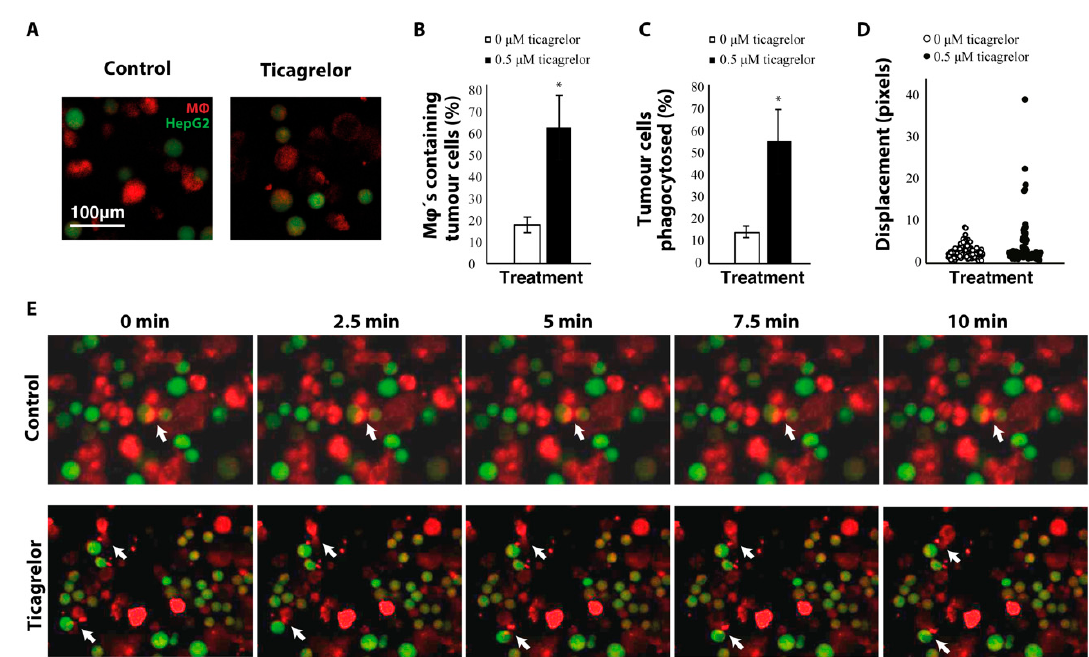
Figure 4. Ticagrelor enhances phagocytosis of tumor cells. ( A ) Confocal microscopy images of macrophages (M ϕ ) and HepG2 cells stained with CellTracker Red CMTPX and Green CMFDA, respectively. ( B ) quantification of the percentage of macrophages that have phagocytosed tumor cells. ( C ) quantification of the percentage of tumor cells that were removed by macrophages. ( D ) Displacement of macrophages measured on time-lapse videos of the phagocytosis assay. ( E ) time-series of the phagocytosis assay with and without ticagrelor. Arrows represent macrophages actively phagocytosing HepG2-cells * = p < 0.05.